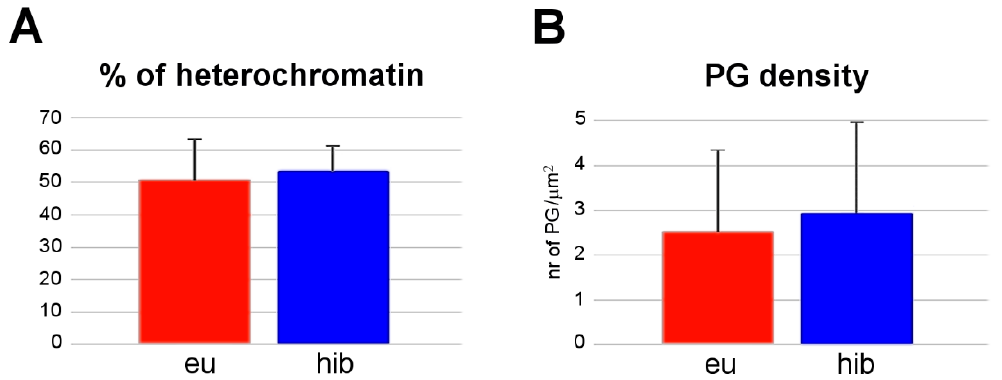
Figure 3. Quantitative evaluation of the percentage of heterochromatin ( A ) and PG density ( B ) (mean ± standard error of the mean (SEM)) in SC nuclei from skeletal muscles of euthermic (eu) and hibernating (hib) dormice. No significant difference was found between euthermia and hibernation for heterochromatin (p = 0.091), whereas PG density was significantly higher in hibernating dormice (p = 0.002).